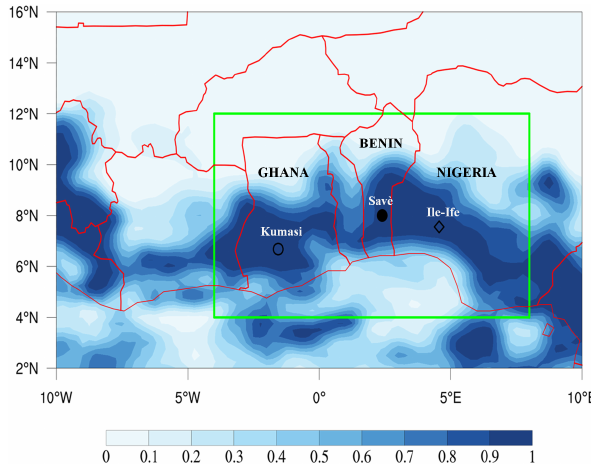
Figure 1. Low-level cloud fraction over West Africa from ECMWF (European Centre for Medium range Weather Forecast) ERA5 reanalyses (Hersbach et al., 2020) averaged between 05:00 and 07:00UTC on 8 July 2016. The fraction varies from 0 (clear sky) to 1 (totally covered sky). The red lines represent the geopolitical boundaries. The green box delimits the area of interest during the DACCIWA field campaign. The black markers indicate geograph- ical locations of the DACCIWA ground supersites: Savè in Benin (filled circle), Kumasi in Ghana (unfilled circle) and Ile-Ife in Nige- ria (unfilled